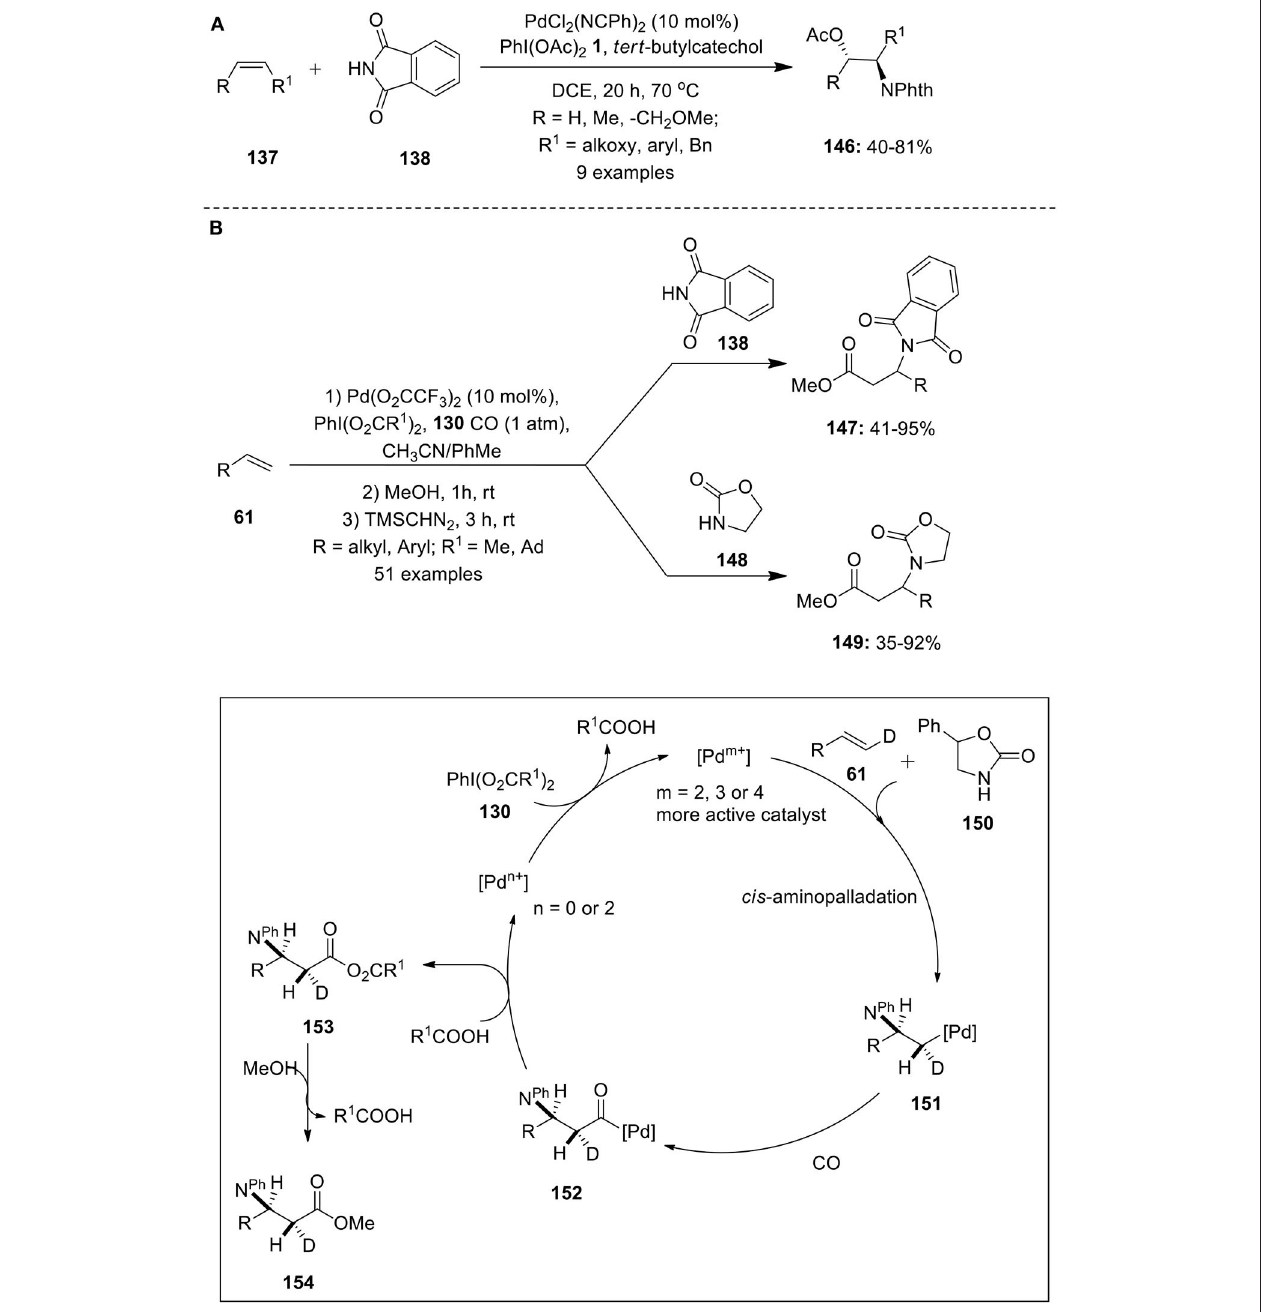
intramolecular carboacetoxylation protocol for the preparation of acetoxymethyl-substituted cyclopentane derivatives via oxidative cyclization of 4-pentenyl-substituted malonate esters employing bis(acetonitrile)dichloropalladium catalyst and oxidant PhI(OAc) 2 1 was developed (Fujino et al., 2010). The reaction was performed in the presence of